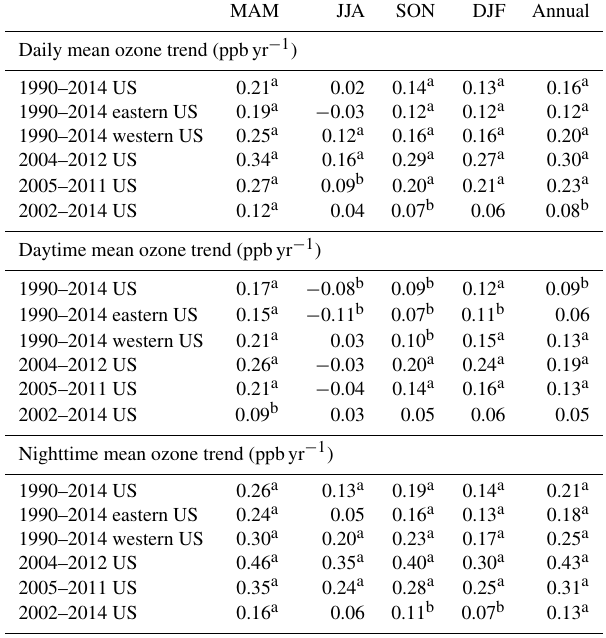
a P value<0.01. b P value<0.05 after an F test.